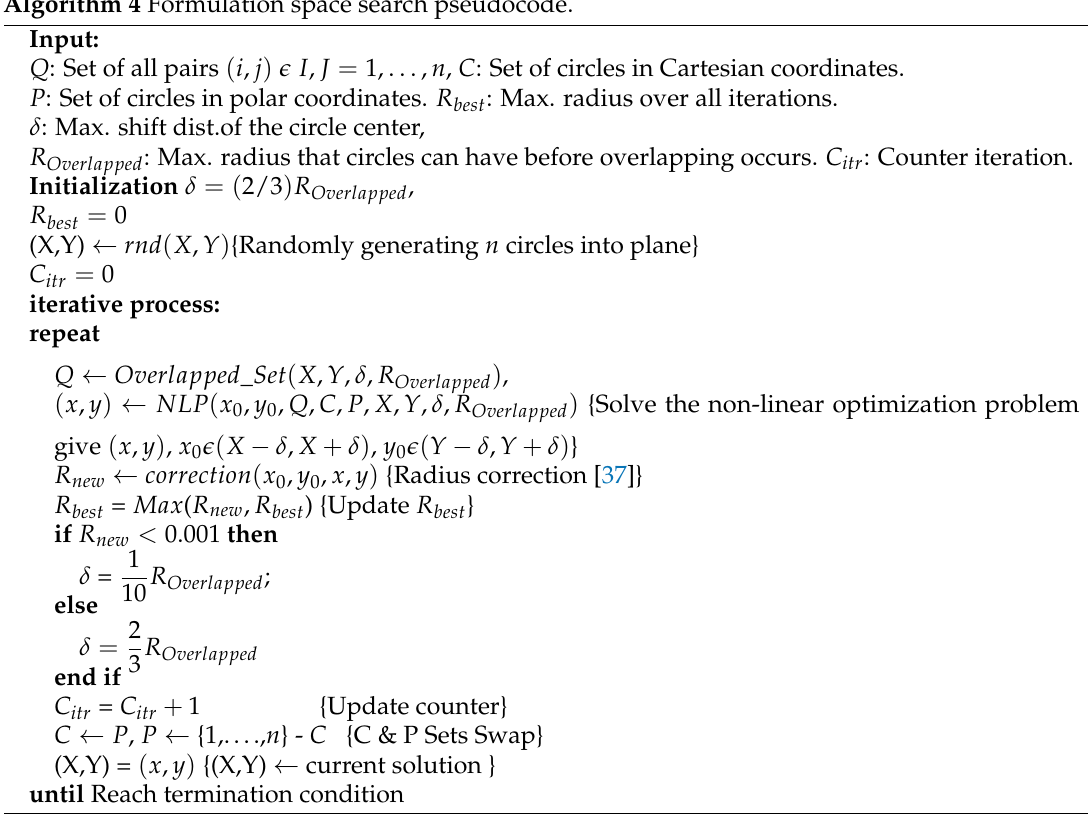
Algorithm 4 Formulation space search